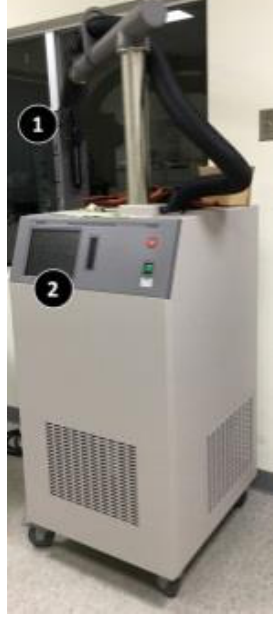
Figure 3. The Thermonics T-2500SE temperature forcing system.